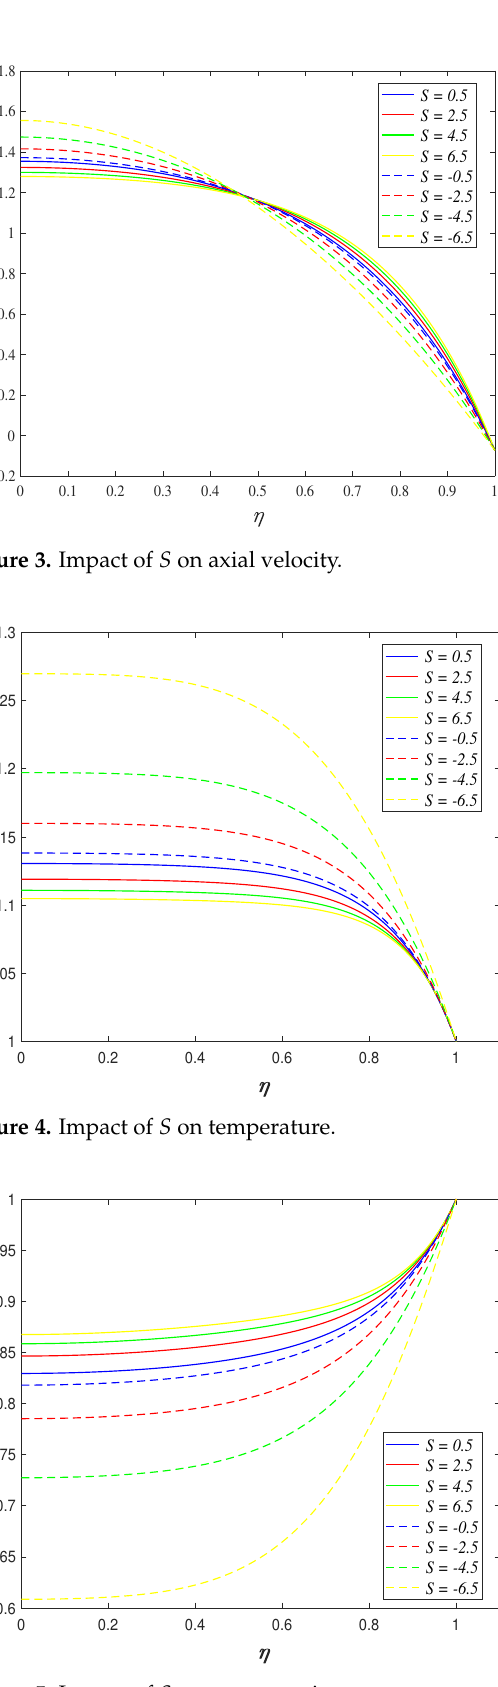
Figure 5. Impact of S on